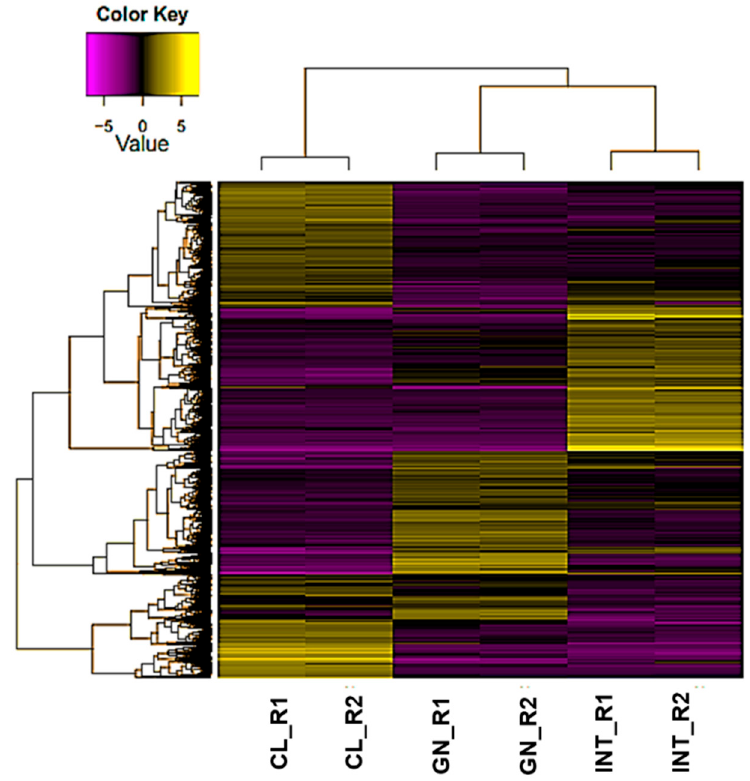
Figure 5. The heat map showed differentiated clustering of expressed transcripts according to respective expression values across tissues. Parameters: fold change (absolute values > 4.0) and FDR corrected p value ( p < 0.001). Abbreviations: CL: coelomocyte, INT: intestine, GN: gonad. R1: Replicate 1, R2: Replicate 2.